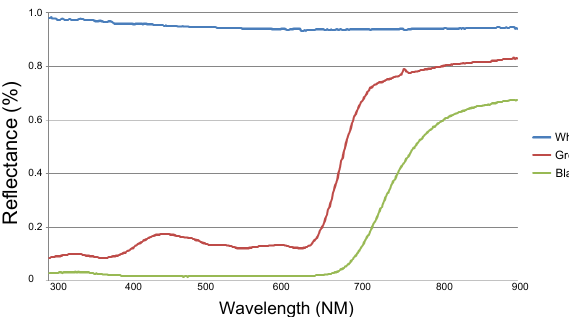
White Grey Black